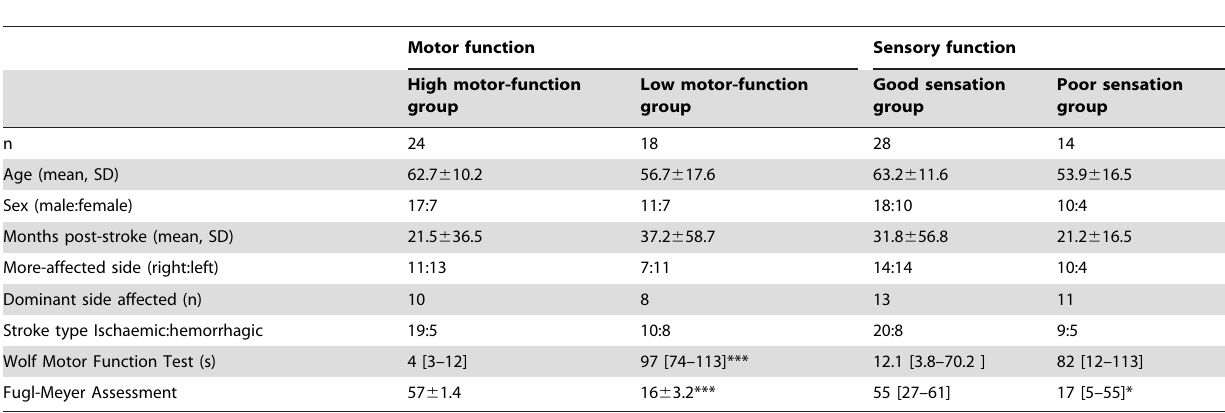
Table 1. Demographic data and motor scores of stroke patients classified by more-affected side motor-ability and sensory function.